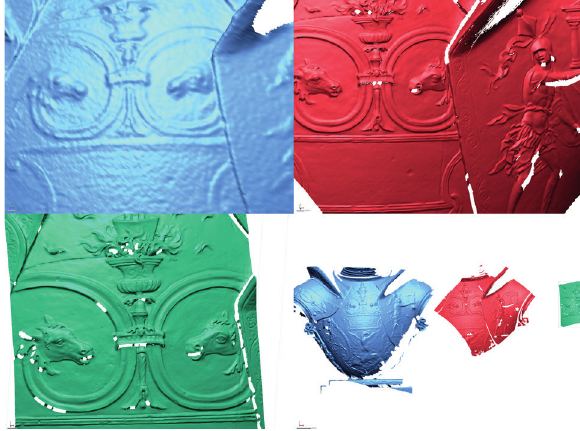
Figure 3: comparison between three scans of the same detail.